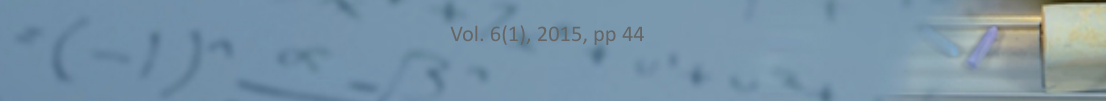
Description: (Fig. 2) The applet simulates the composition of two velocities at equal or different angles: the downstream velocity of water in a river and the velocity of a jet ski relative to